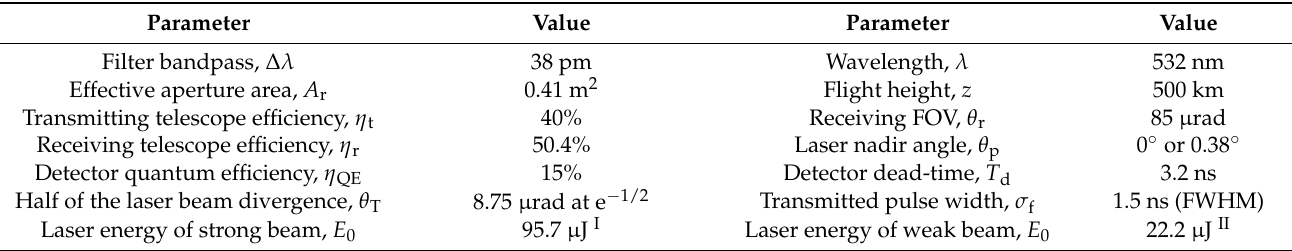
Table 2. System parameters of the Ice, Cloud, and land Elevation Satellite-2 (ICESat-2) advanced topographic laser altimeter system (ATLAS).